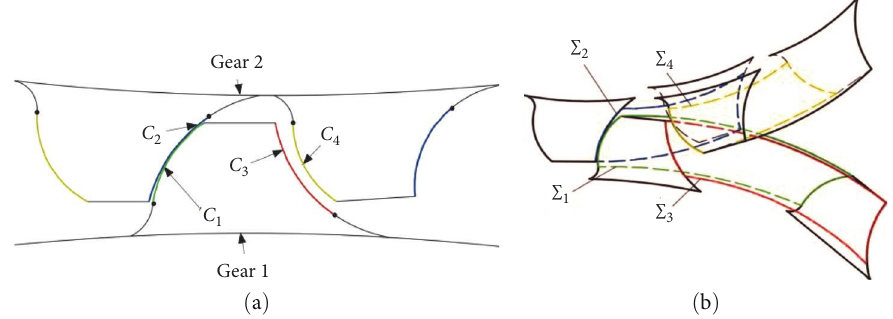
F IGURE 3: Introduction of the asymmetric logarithmic spiral gear tooth pro fi le.